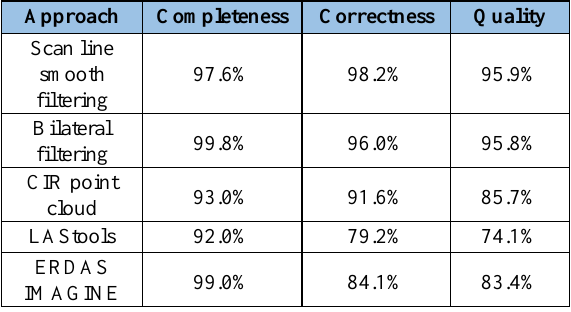
Table 1. Evaluation of the automatic detection of building points results.